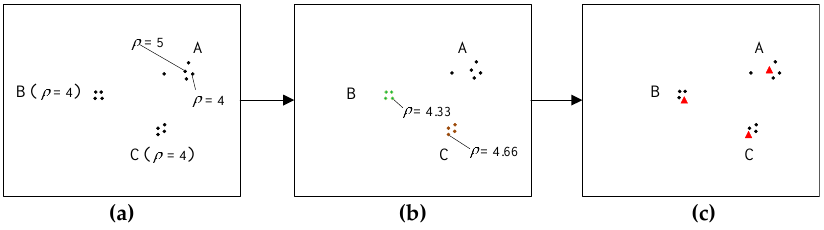
Figure 4. An example of adjusting the density. ( a ) The initial points; ( b ) For the points which have the same density, recalculate the density; ( c ) Choose the centers.